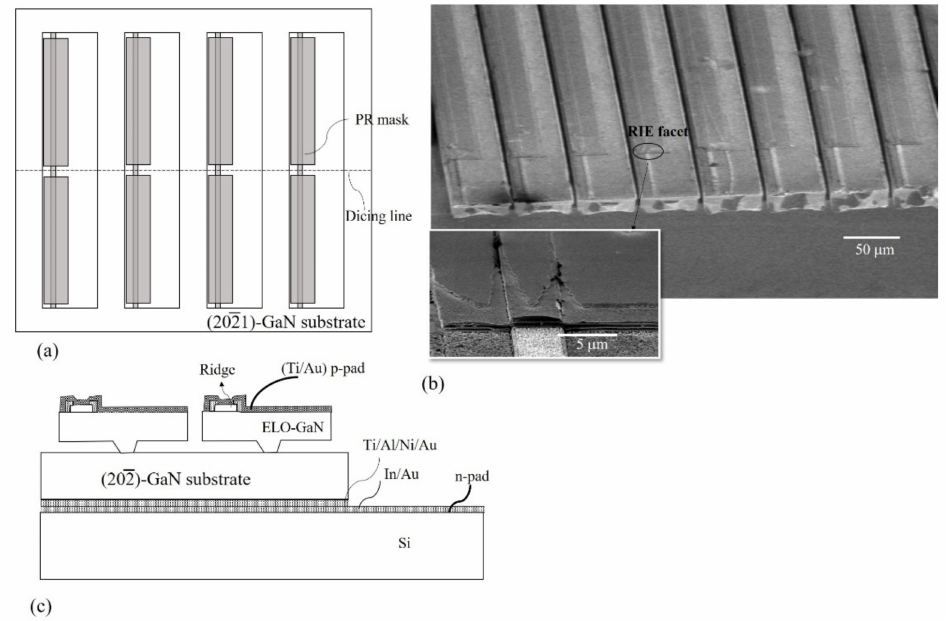
Figure 4. Schematic for on-wafer facet etching: ( a ) PR-masked ELO wing LDs on {2021 } semipolar GaN substrate. ( b ) SEM images of on-wafer RIE etched facets of ELO wing LDs. ( c ) Probing scheme for on-wafer RIE facet ELO wing